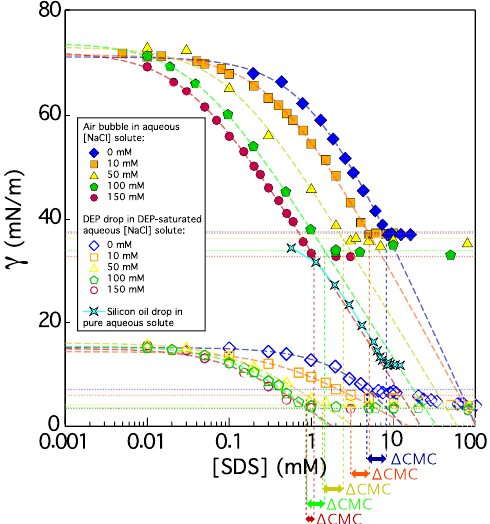
FIG. 3. Surface tension versus SDS concentration at the inter- face of an air bubble in aqueous [NaCl] solution (filled symbols), a DEP drop in DEP-saturated [NaCl] aqueous solution (open symbols), and a silicone oil drop (350 centiStokes) in pure aqueous solution (crosses). As a function of [NaCl], fits to the von Szyszkowski equation (dashed lines) reveal that the surface tension gradient is independent of salt concentration for a given interface. The CMC decreases with salt for both the aqueous and the DEP-saturated interface, but the difference Δ CMC is progressively smaller.